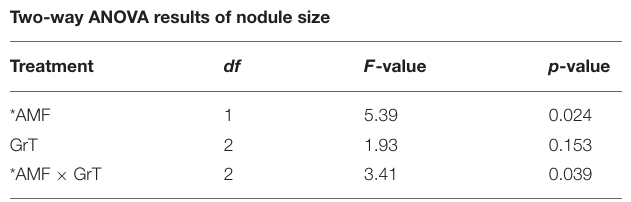
TABLE 5 | Two-way ANOVA results of nodule size in rhizobia and AMF + rhizobia treated host plants under gravitational treatments (GrT). Two-way ANOVA results of nodule